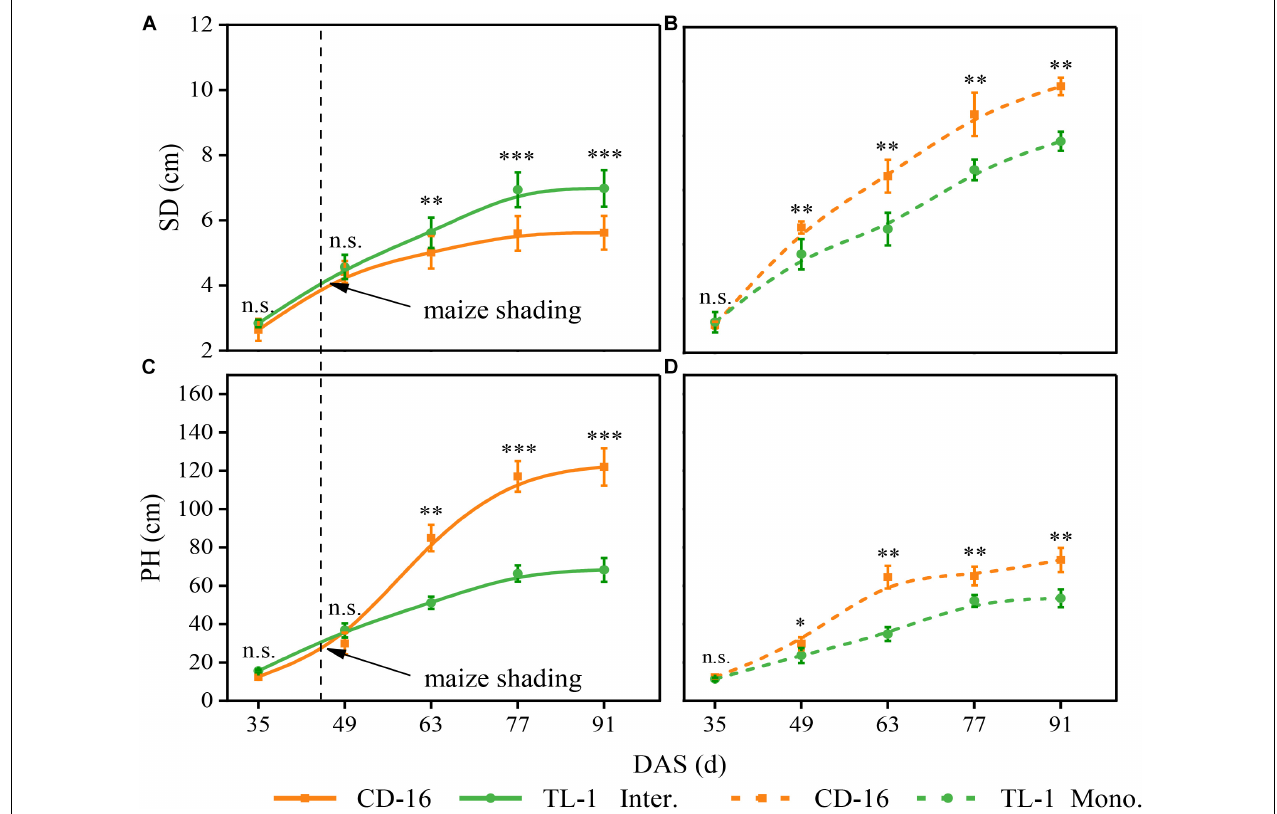
FIGURE 7 | Effects of different cultivars and planting patterns on SD (A,B) and PH (C,D) . The ∗ , ∗∗ , and ∗∗∗ indicate significant differences between CD-16 and TL-1 at the levels of p < 0.05, p < 0.01, and p < 0.001, respectively. The n.s. means not significant at the level of p ≥ 0.05. The vertical black dotted line indicates that the maize begins to shade the intercropping soybean at this time. Data are average of three replicates. Error bars represent standard errors. The solid line indicates strip intercropping, and the dashed line indicates monoculture. Mono. and Inter. are the abbreviation of monoculture and strip intercropping, respectively. DAS represents the number of days after sowing. TABLE 3 | The number of vascular bundles and the area ratio of vascular/stem, phloem/stem, xylem/stem, and pith/stem response to planting patterns and soybean cultivars at R1 stage. Treatment Vascular Vascular/stem Phloem/stem Xylem/stem Pith/stem Unit/mm 2 % % %